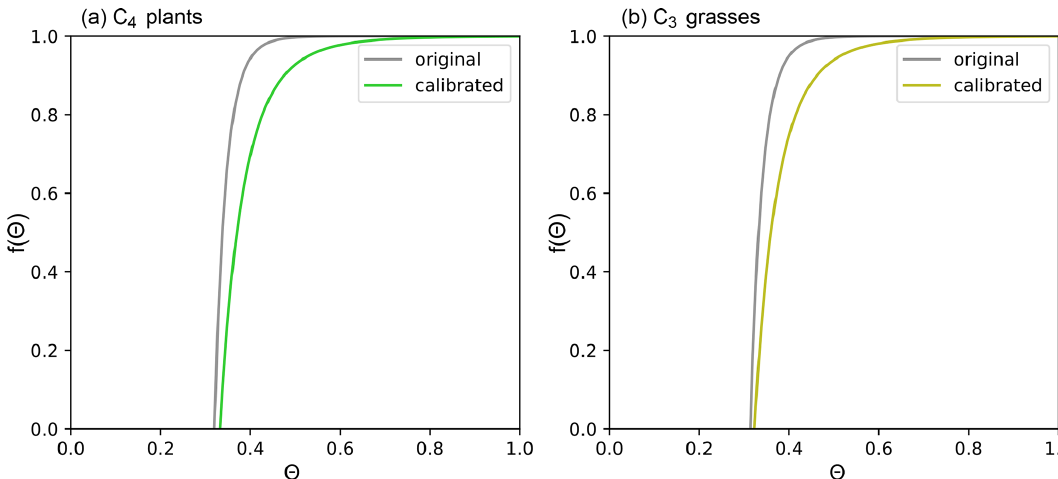
Figure 2. f (θ) calibration for (a) C 4 grasses and (b) C 3 grasses.